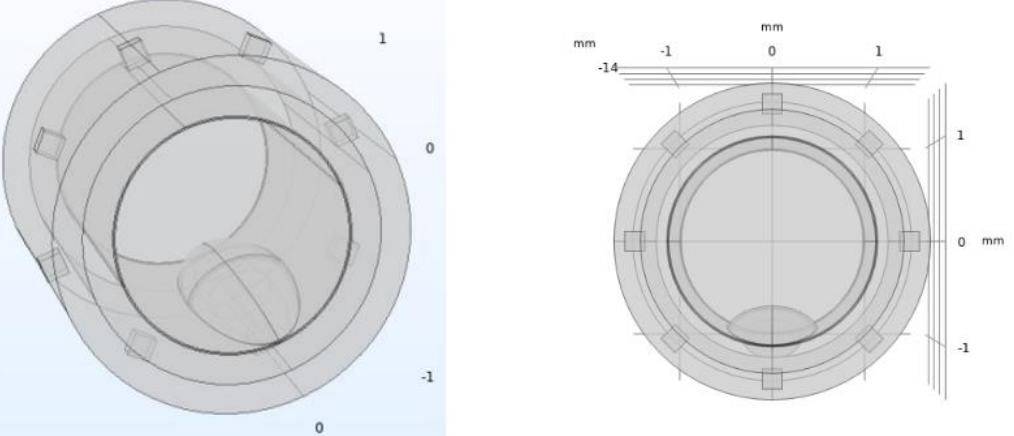
Figure 2. Pathological artery model with atheromatous plaque. The atheromatous plaque is represented at the bottom part of the inner circumference, and it is built from the intersection of different ellipsoids. Eight electrodes for the electrical impedance tomography stem are also represented, surrounding the diameter of the stent, as explained in Section 2.2.